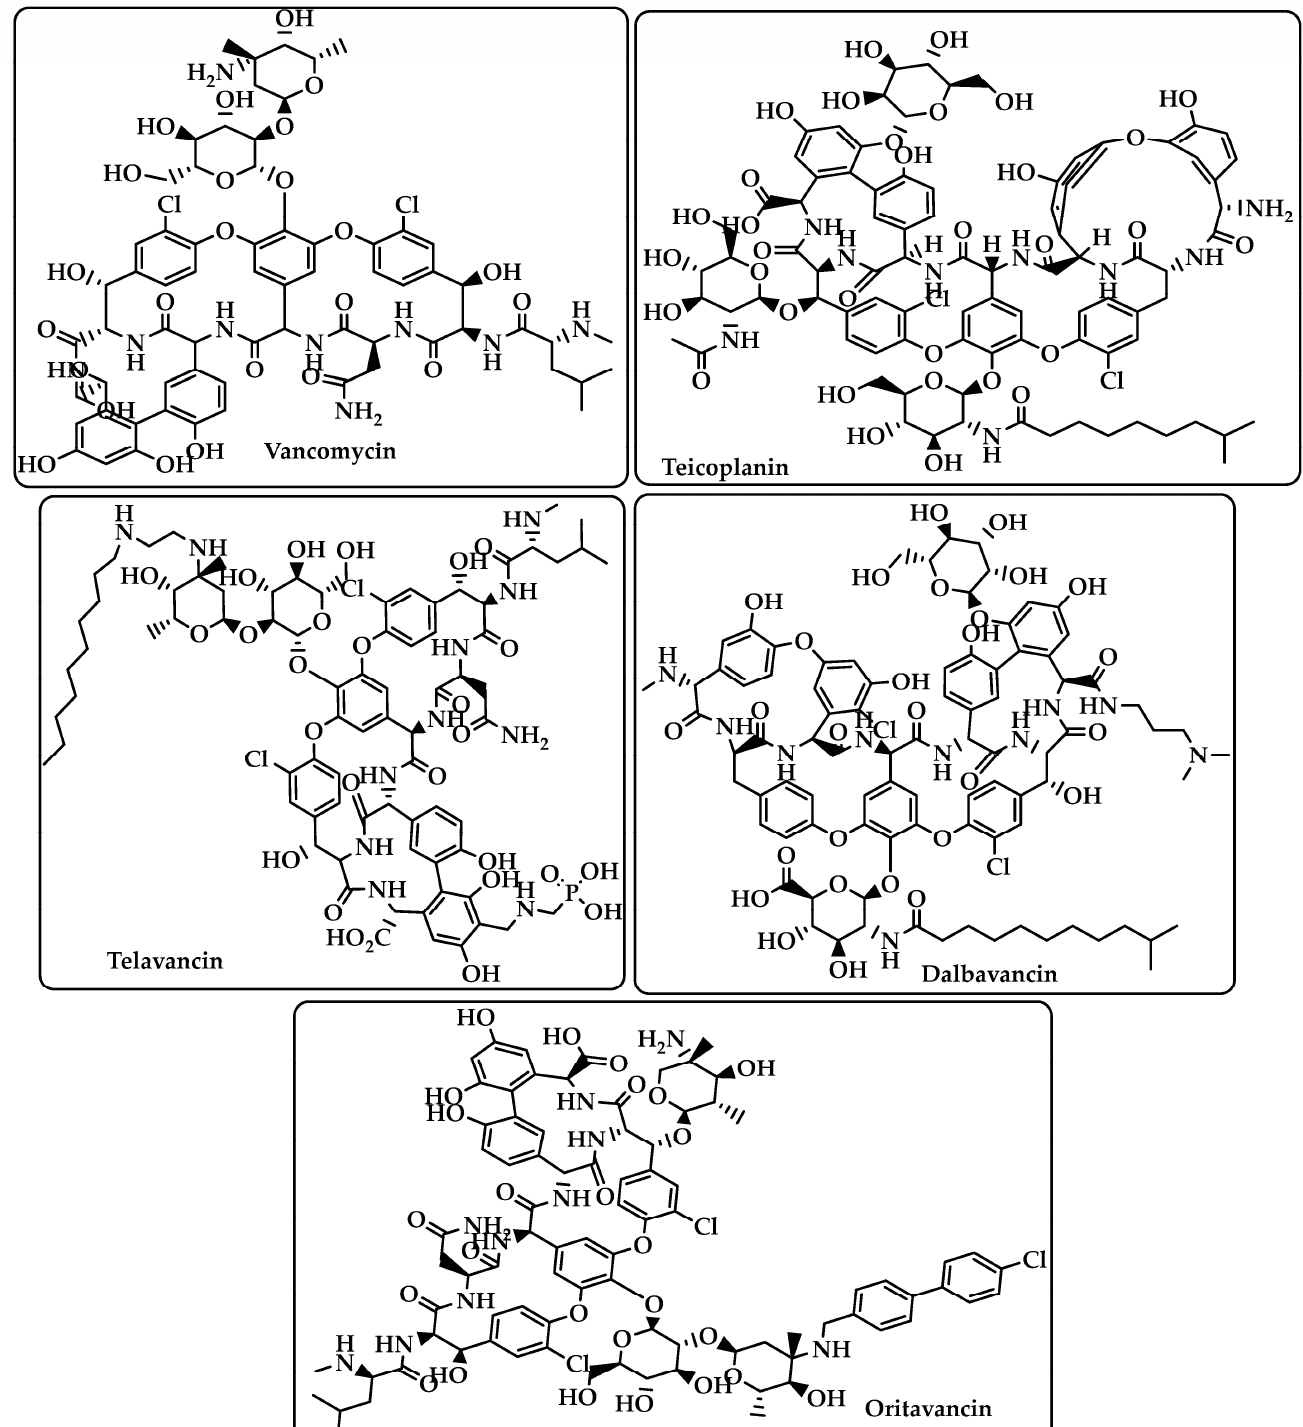
Figure 1. Chemical structure of penicillins, cephalosporins, carbapenems, monocyclic β - lactams, clavulanic acid ( β -lactamase inhibitors), vancomycin, teicoplanin, telavancin, dalbavancin, and